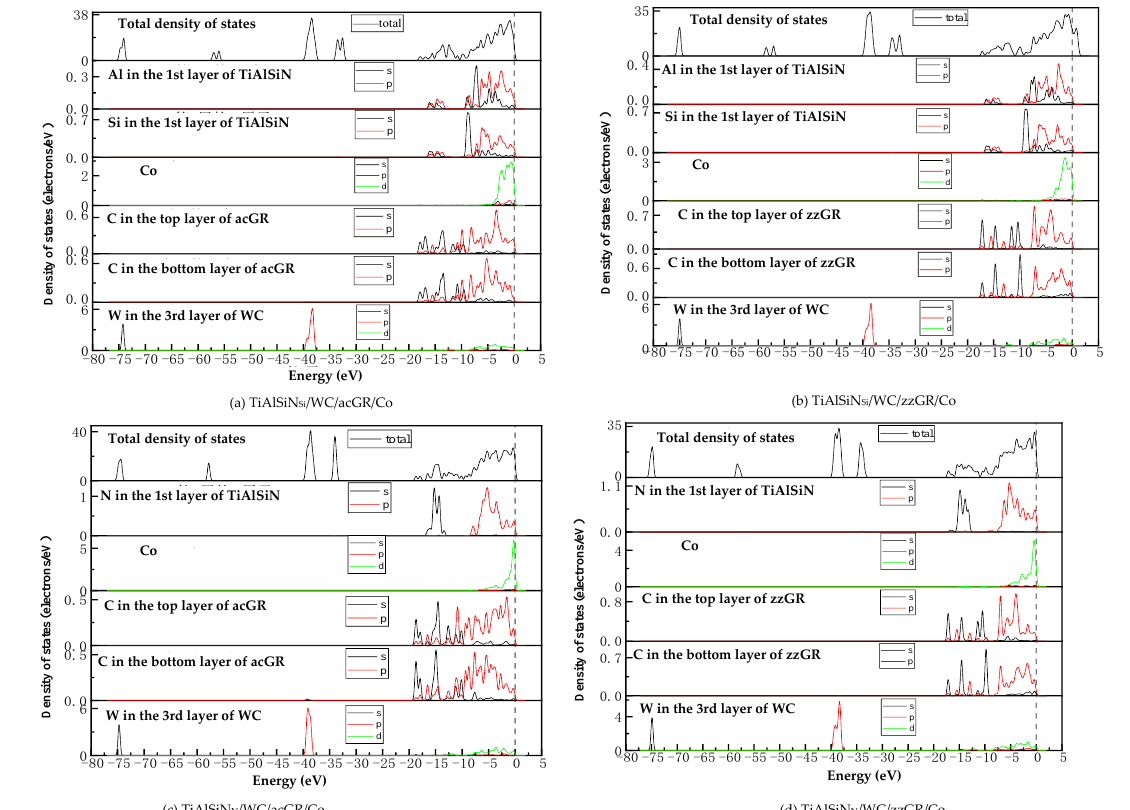
Figure 16. TDOS and PDOS of the interface models with the matrix doped with an intrinsic graphene boundary.